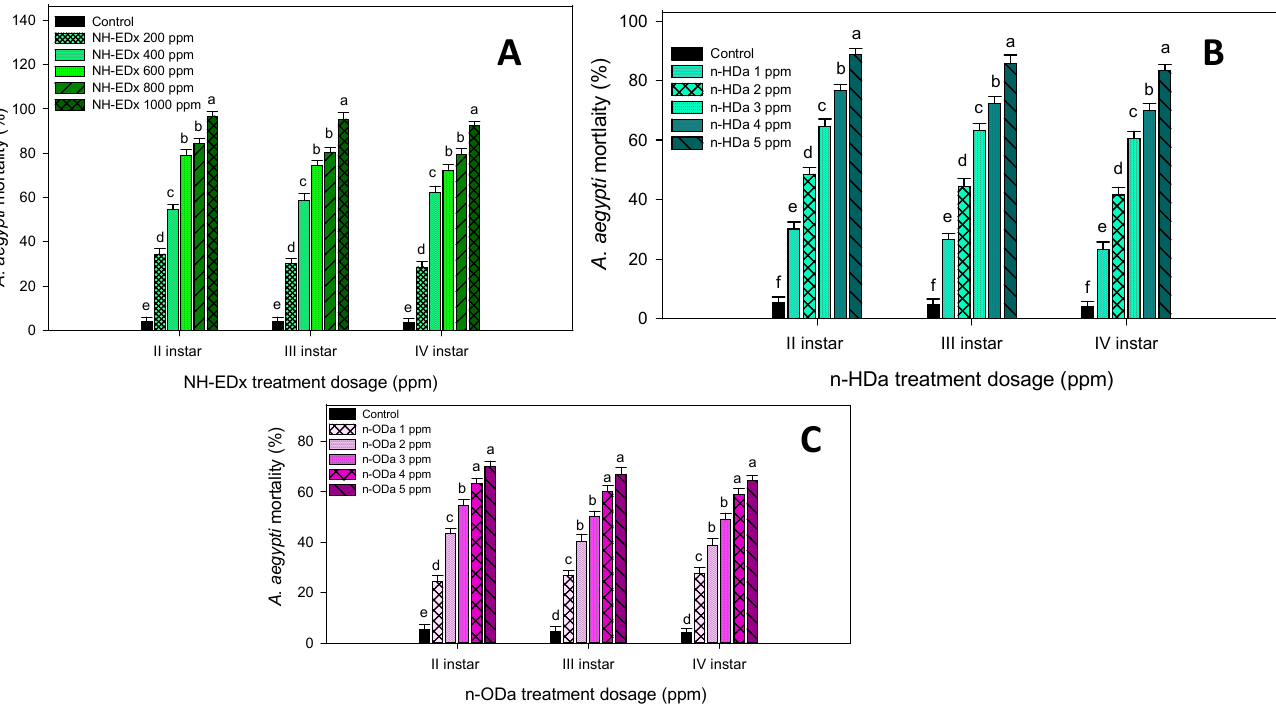
Figure 2. Percentage mortality of second, third, and fourth instar larvae of A. aegypti after treatment with NH-EDx ( A ), n -HDa ( B ), and n -ODa ( C ). Means (±SEM) followed by the same letters above bars indicate no significant difference ( p ≤ 0.05) according to a Tukey’s test.